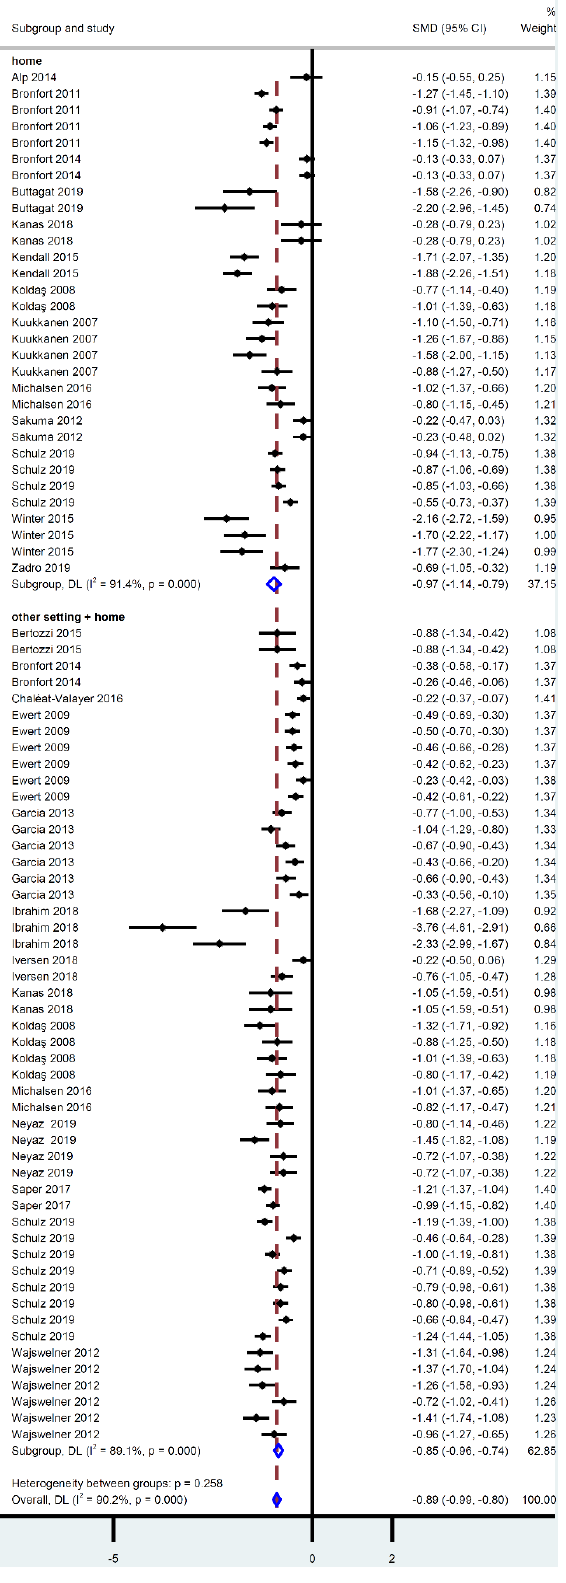
Figure 4. Meta-analysis on the effect of home-based exercise on pain intensity, stratified by setting (exclusive home-based training versus home-based and other setting).